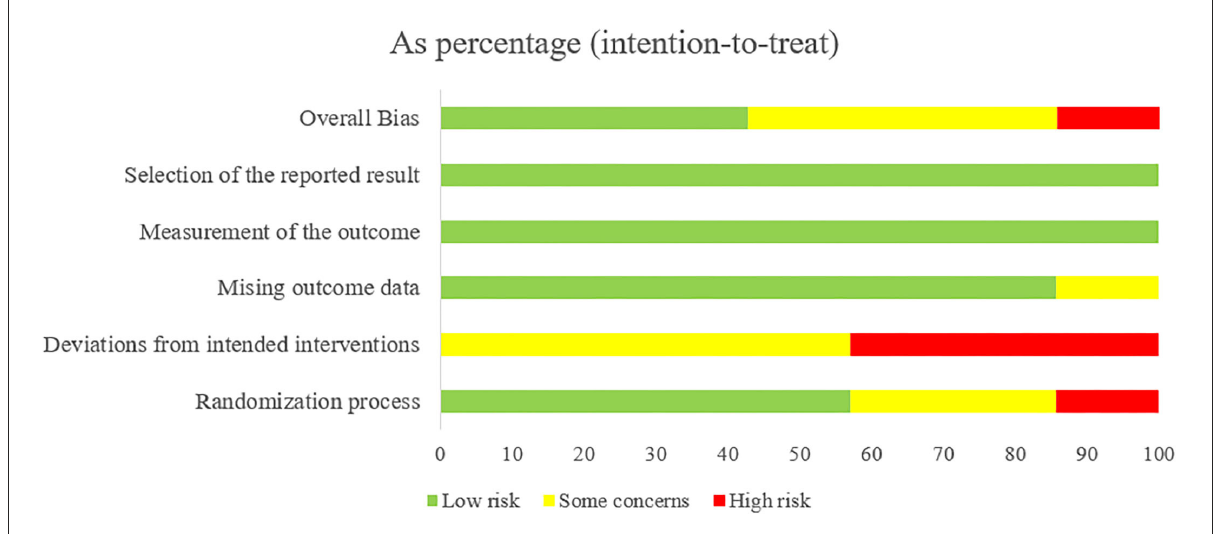
FIGURE2 Risk of bias summary: review authors’ judgments of each risk of bias item presented as percentages across all included